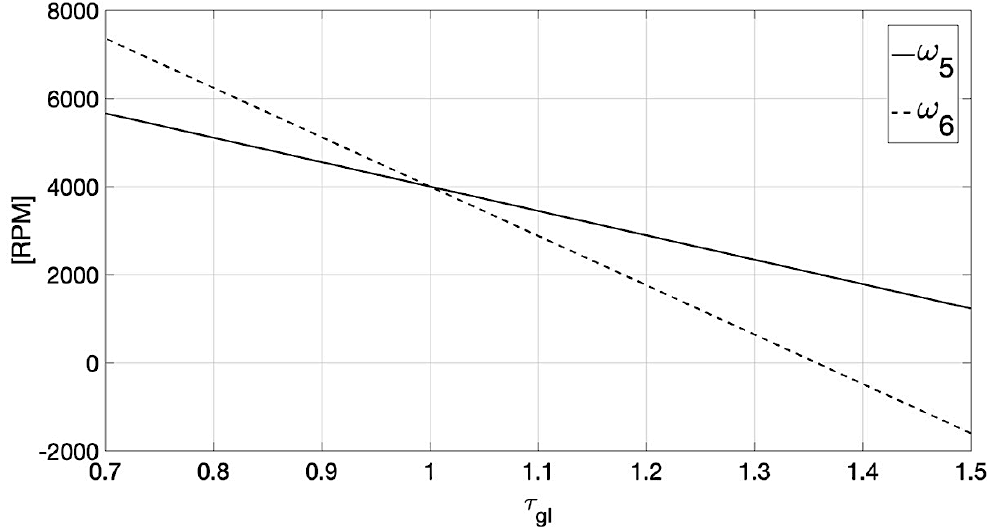
Figure 5. Speed of the electric machines as a function of the global transmission ratio.